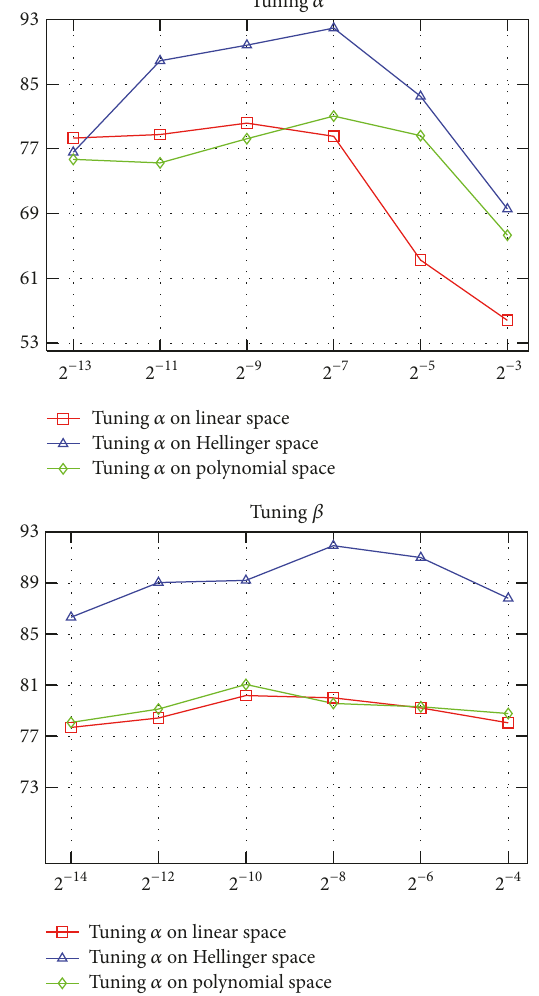
Figure 2: Parameter tuning on the Extended YaleB